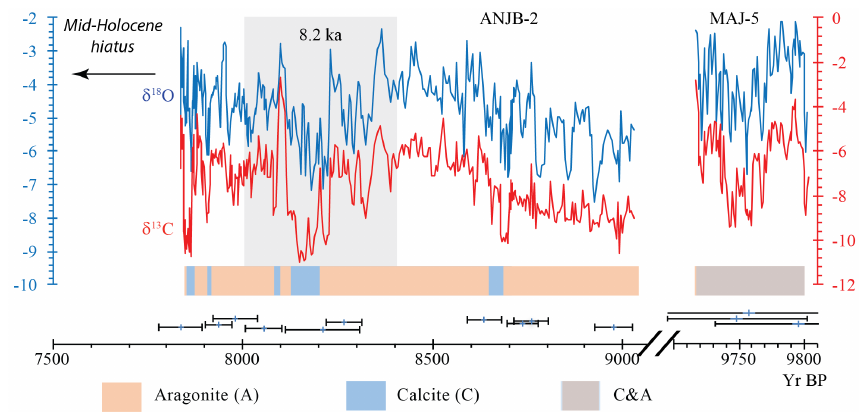
Figure 5. Variations in δ 13 C, δ 18 O, and mineralogy in Stalagmite ANJB-2 and Stalagmite MAJ-5 during the Malagasy early Holocene interval. Supplement Fig. S6 shows both the corrected and uncorrected isotope values.